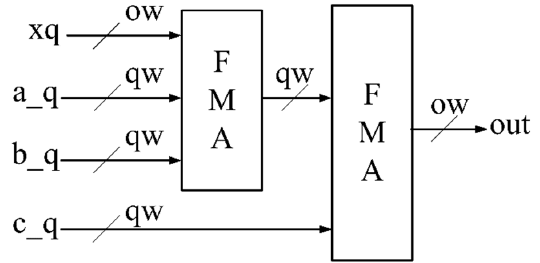
Figure 8. Arithmetic circuits regarding the proposed quantizer.